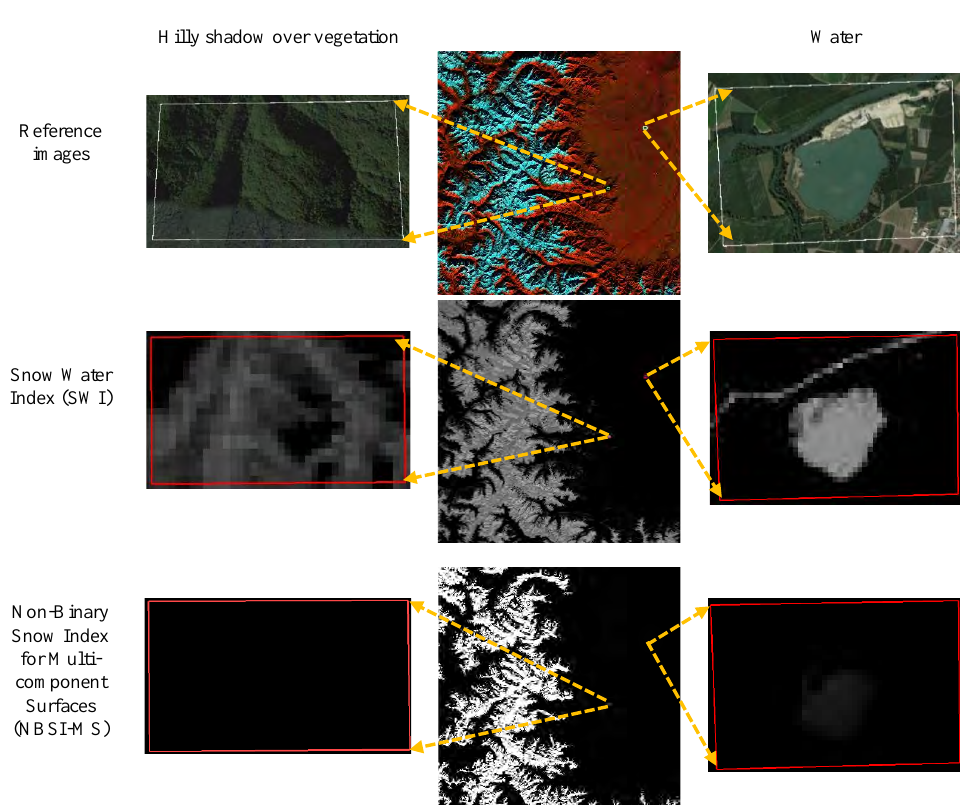
Figure 11. Comparison of the performance for the NBSI-MS and SWI methods. The reference images of Hilly Shadow over Vegetation (HS-V) and water are high resolution taken with Google Earth Pro TM , while the center reference image is the false color used to visualize snow in blue. On the left column, the extracted HS-V areas are shown. The middle images are the resulting snow maps representing from where the areas were taken. The right side panels represent the extracted water areas. It can be seen that the NBSI-MS was capable of rejecting the water and HS-V surface with better performance compared with the SWI method since the images show dark results, while the SWI presents gray